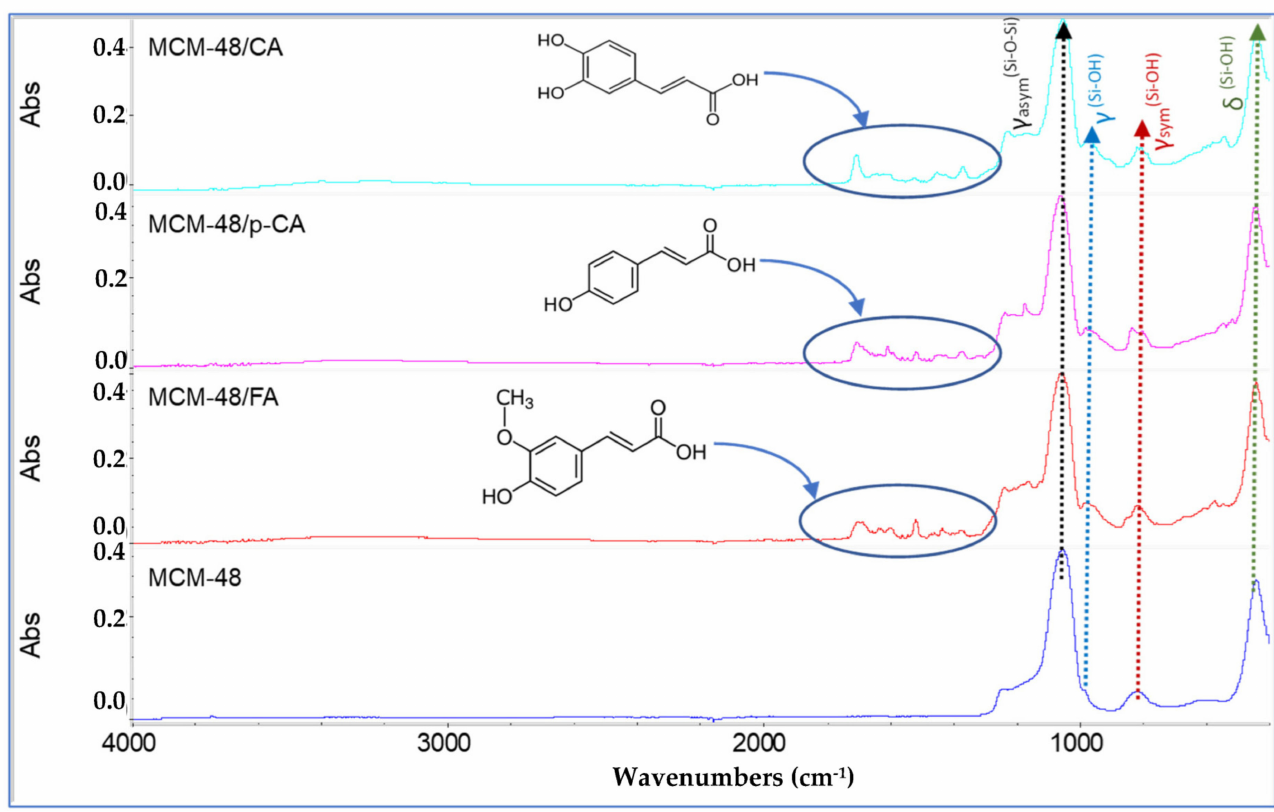
Figure 8. FTIR spectra of samples MCM-48, MCM-48/CA, MCM-48/p-CA and MCM-48/FA. As in the case of the MCM-48 material, the loading of the MCM-48 mesoporous material with the three polyphenols induces changes in the MCM-48 characteristic band from 1050.35 cm − 1 and 436.91 cm − 1 (Figure 9) at 1049.53 cm − 1 and 436.25 cm − 1 (i.e., 0.82 cm − 1 and 0.68 cm − 1 ) in the case of MCM-48 loading with caffeic acid; at 1054.63 cm − 1 and 437.15 cm − 1 (i.e., 4.28 cm − 1 and 0.24 cm − 1 ) in the case of MCM-48 loading with p- coumaric acid; and from 1050.35 cm − 1 and 436.91 cm − 1 to 1053.84 cm − 1 and 436.88 cm − 1 (i.e., 3.49 cm − 1 and 0.03 cm − 1 ) in the case of MCM-48 loading with ferulic acid, respectively. These smaller shifts can be explained by a lower interaction of polyphenols with the mesoporous